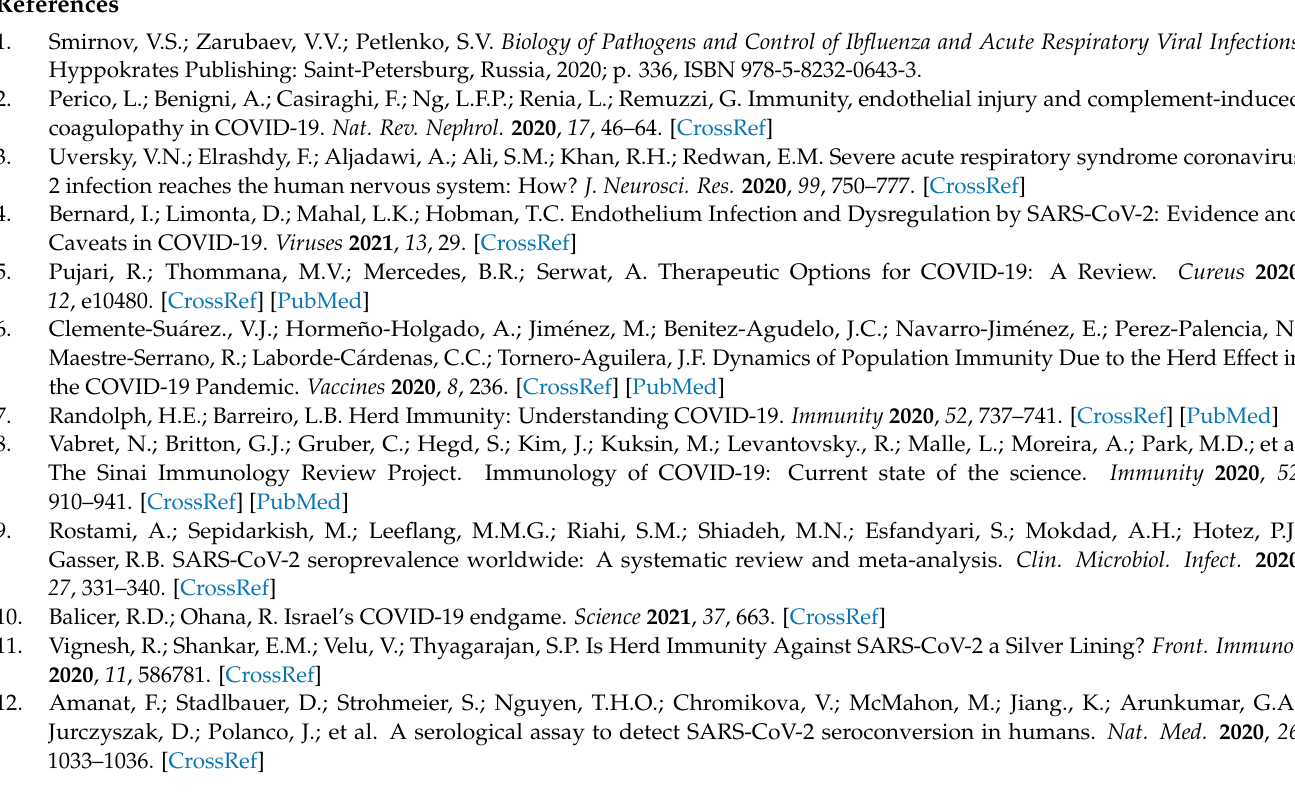
Volunteer numbers, by administrative region. Table S3: Distribution of (SARS-CoV-2) seropositive volunteer proportions. Table S4: Distribution of seropositive, asymptomatic volunteers by age and area of